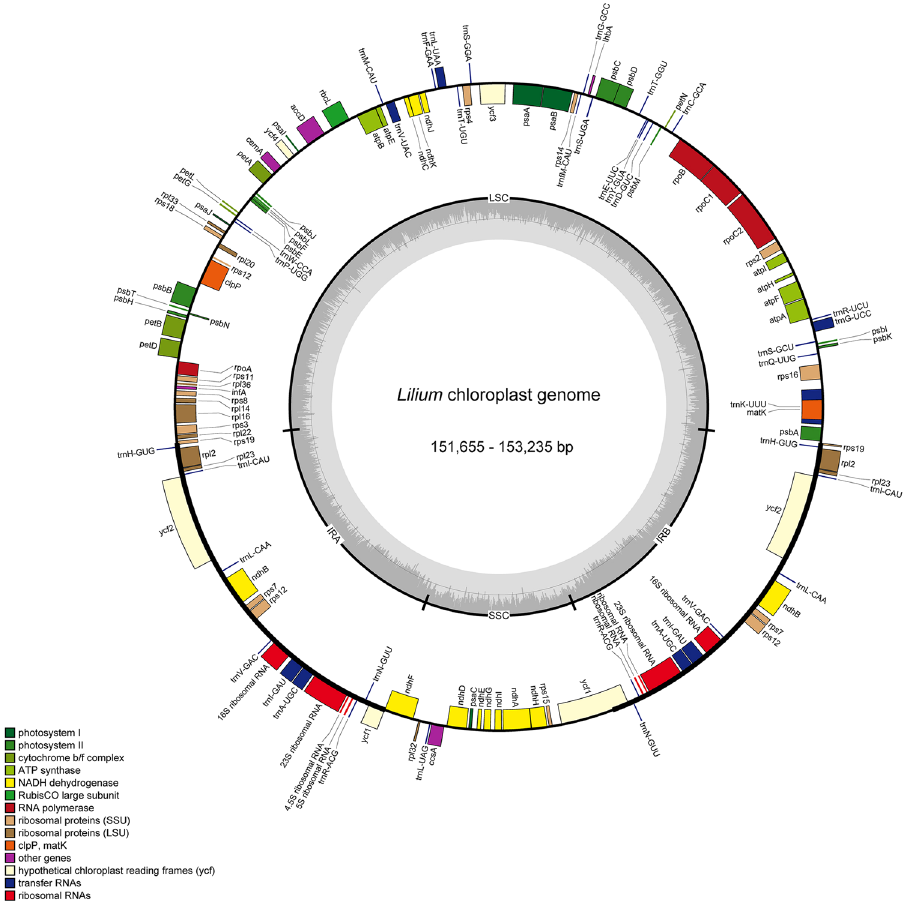
Figure 1. Gene map of the 16 Lilium chloroplast genome. The genes inside and outside of the circle are transcribed in the clockwise and counterclockwise directions, respectively. Genes belonging to different functional groups are shown in different colors. The thick lines indicate the extent of the inverted repeats (IRa and IRb) that separate the genomes into small single copy (SSC) and large single copy (LSC) regions.